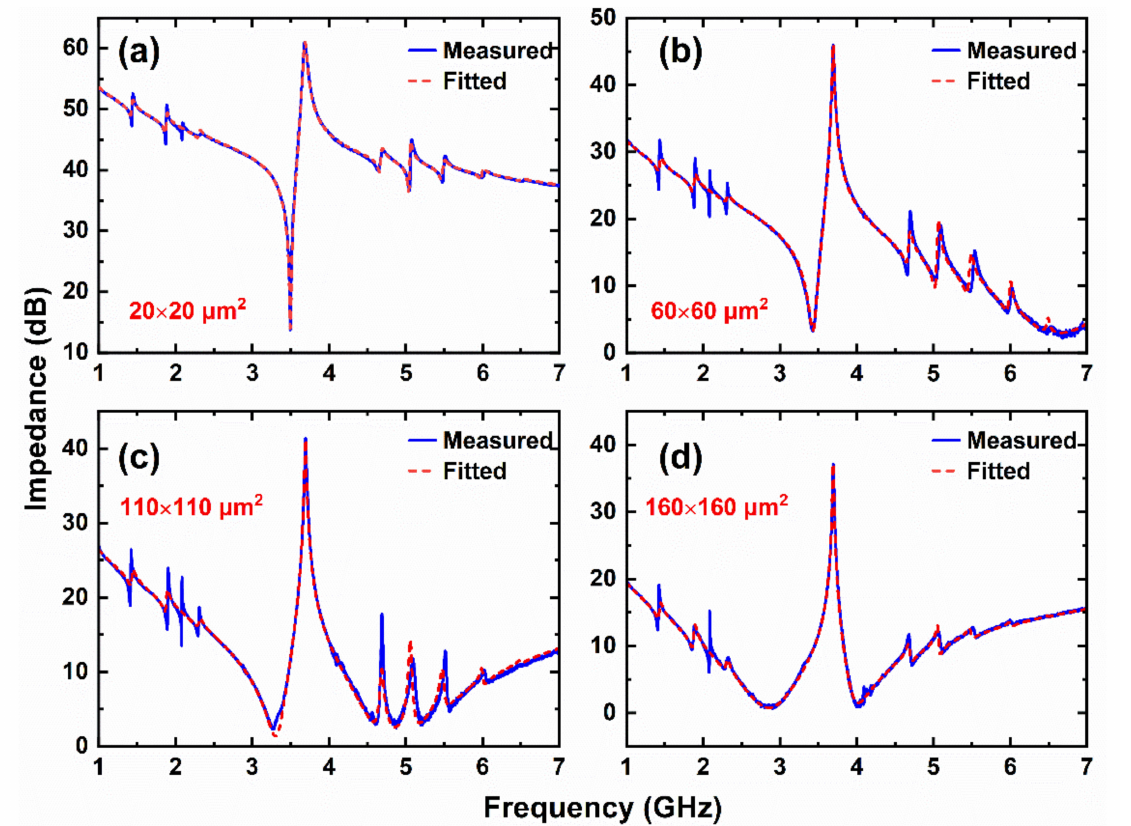
Figure 10. Measured impedances and fitted impedance curves by the Mason model with R s = 1.09 Ohm. ( a ) L s = 0.174 nH with a resonant area of 20 × 20 µ m 2 ; ( b ) L s = 0.173 nH with a reso- nant area of 60 × 60 µ m 2 ; ( c ) L s = 0.185 nH when the resonant area is 110 × 110 µ m 2 ; ( d ) L s = 0.174 nH when the resonant area is 160 × 160 µ m 2